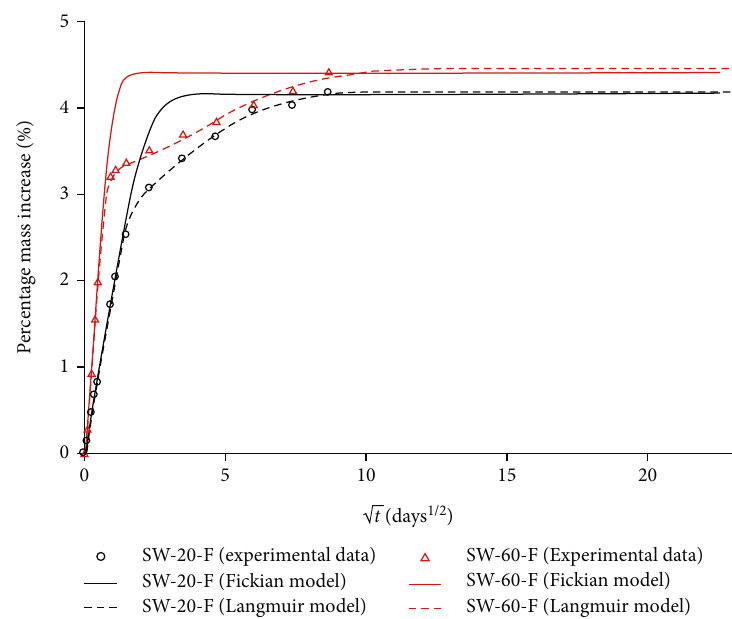
Figure 4: Mass uptake in pure epoxy at 20 ° C and 60 ° C. Reproduced with permission (Copyright Wiley Online Library,